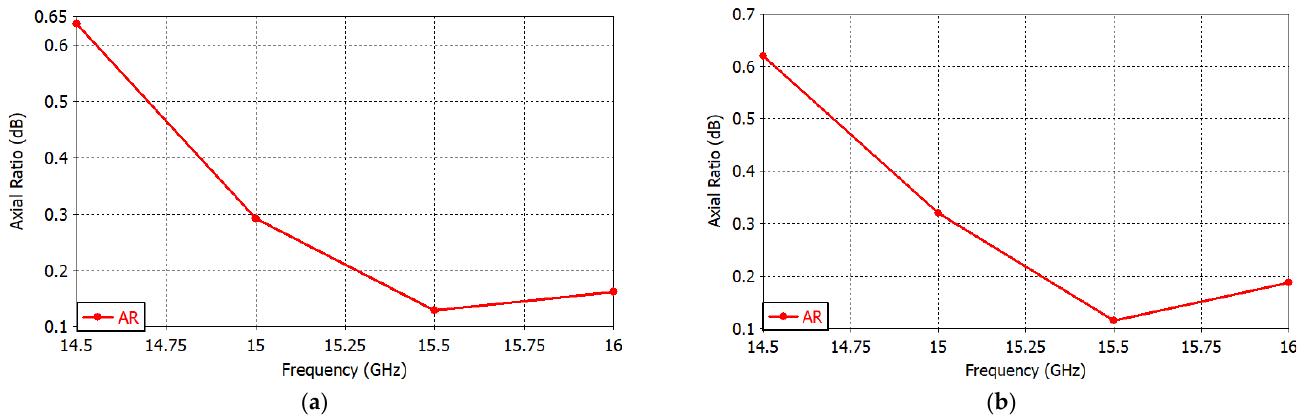
Figure 17. Axial ratio versus frequency. ( a ) Feed. ( b ) Reflector.